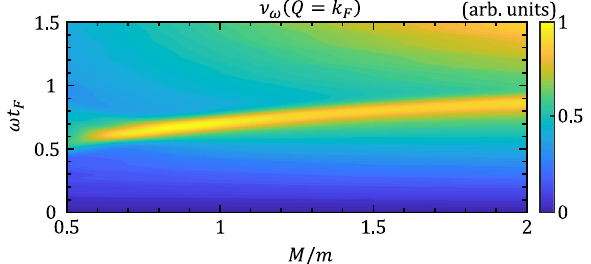
FIG. 10. The DOS at Q ¼ k mass ratio M=m . Parameters are the same as in Fig.